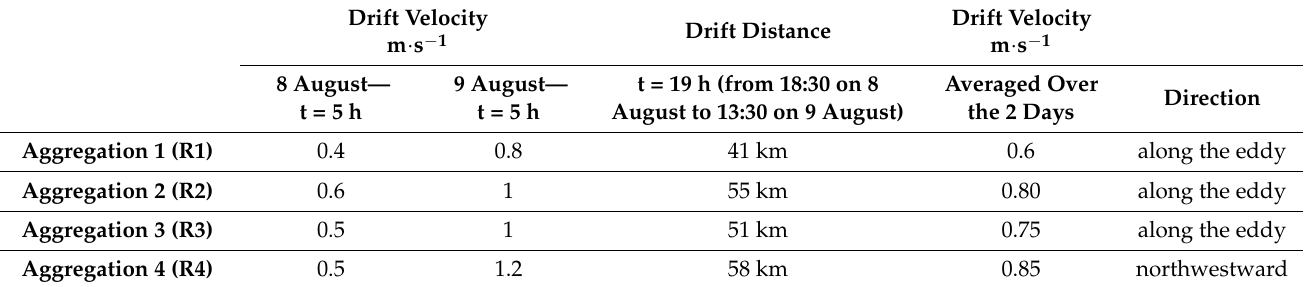
Table 1. Estimation of drift for the four Sargassum aggregations indicated in Figure 10.